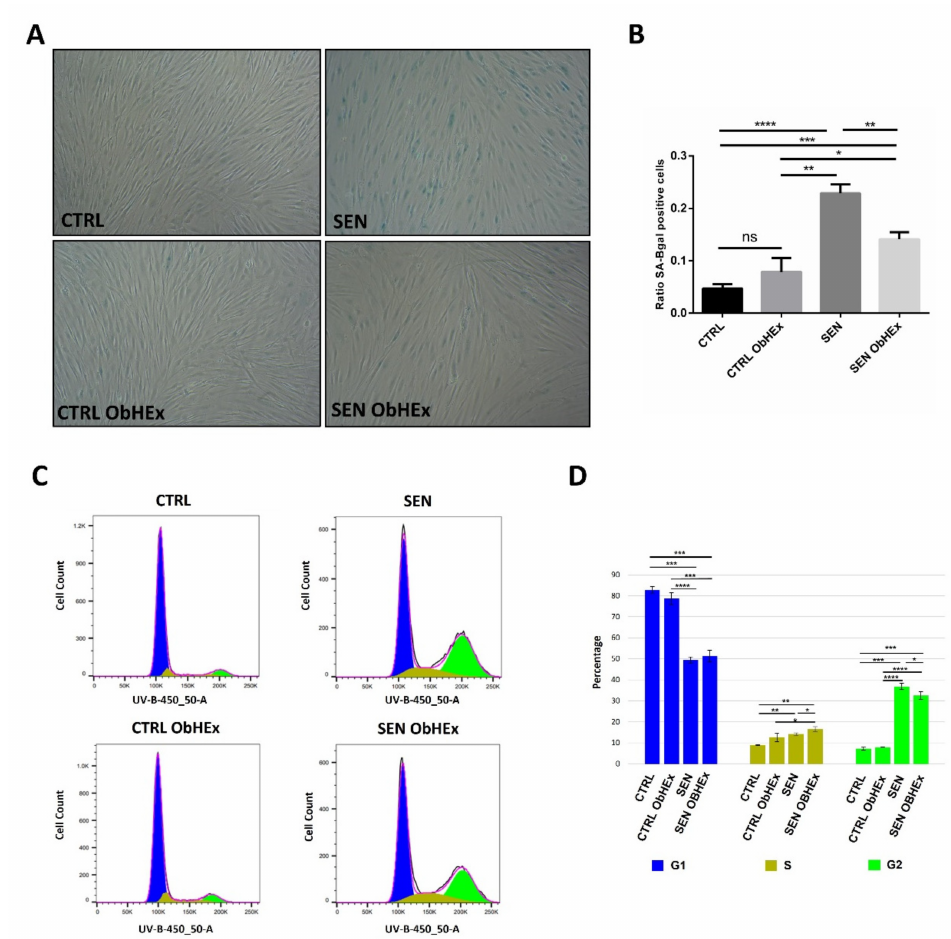
Figure 5. ( A ) Images ( 40 × magnification) of the control and senescent NHDF cells treated or not with ObHEx after the senescence-associated ß-galactosidase (SA-ß-gal) assay. Positive cells are blue. ( B ) Bar graph showing the ability of ObHEx to reduce SA-ß-gal activity. ( C ) DNA profiles of proliferating and senescent fibroblasts after treatment with ObHEx or not, and ( D ) related bar graph. The fluorescence intensity of Hoechst 33342 was measured by flow cytometry with a BD LSRFortessa Cell Analyzer using UV laser (355nm) associated to a 450/50 filter set. G1, S and G2/M phases are reported in blue, brown and green, respectively. In each bar graph, the bars represent the standard deviations while asterisks indicate significant variations (* p < 0.05; ** p < 0.01; *** p < 0.001, **** p < 0.0001) according to Student’s t -test. ns = not statically